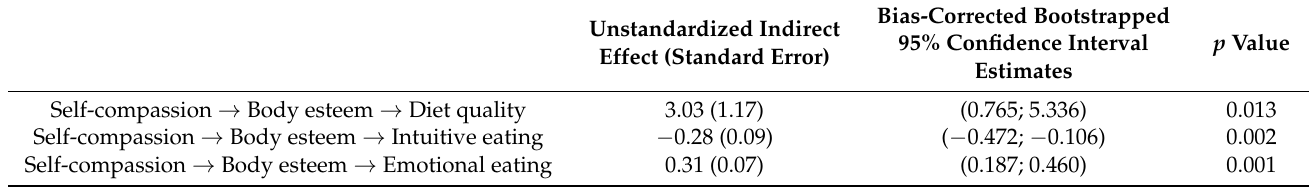
Table 2. Bias-corrected bootstrapped estimated of the